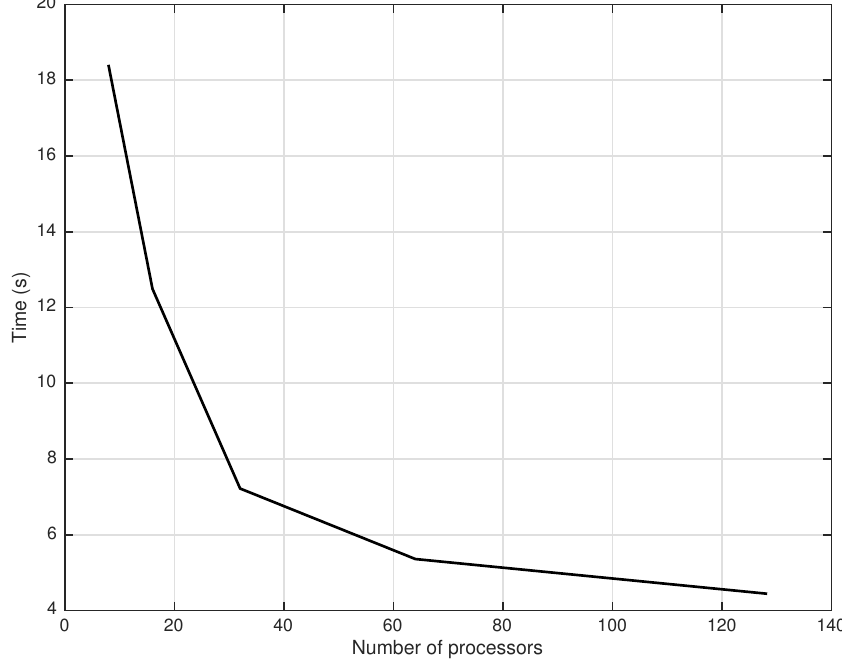
Figure 6. Computational time of asynchronous parareal iterations for fixed time to